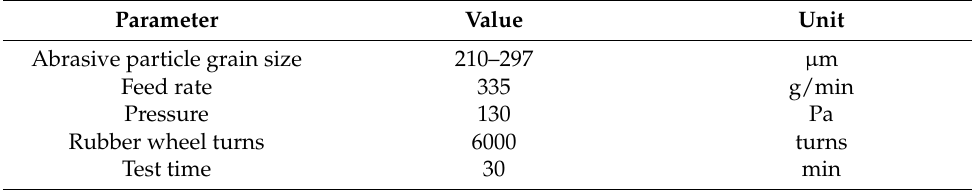
Table 3. Abrasive wear resistance testing conditions.